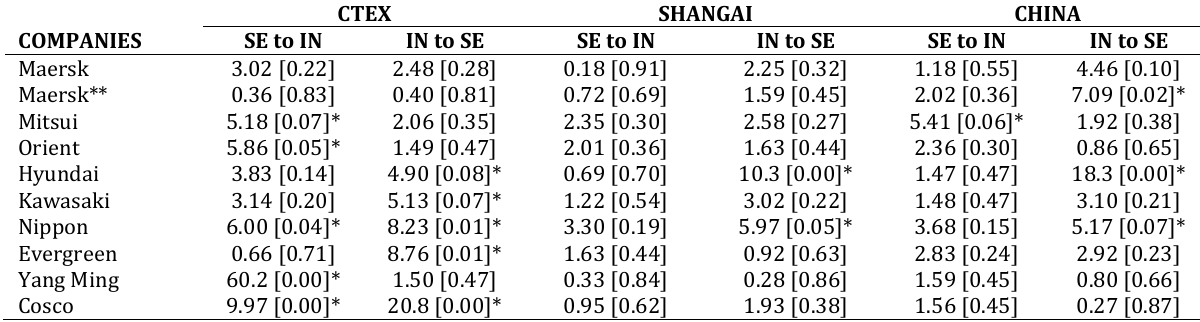
Table 4: Results for causality in variance test CTEX SHANGAI CHINA COMPANIES SE to IN IN to SE SE to IN IN to SE SE to IN IN to